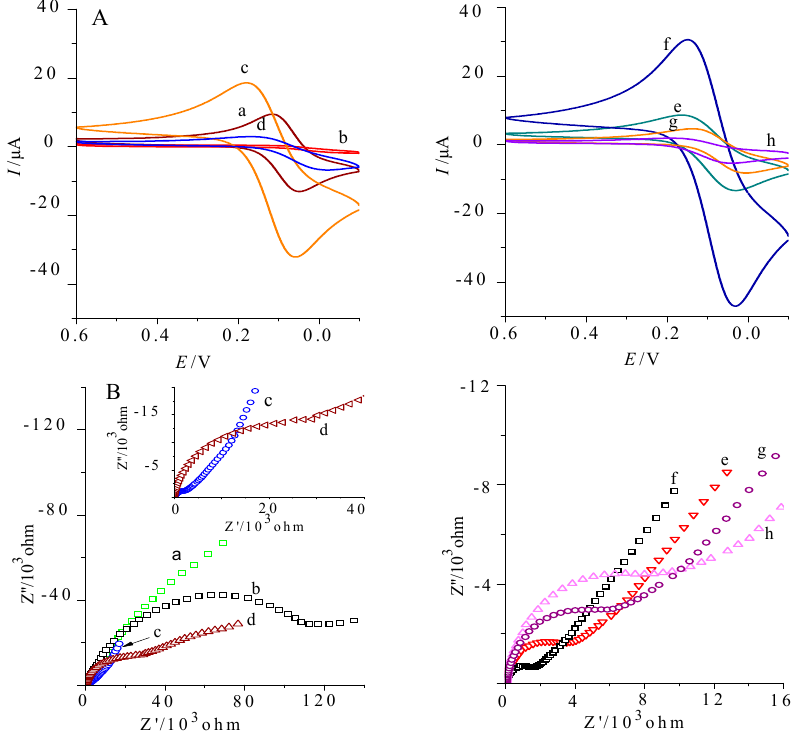
Figure 3. Characterized electrode in modifying process by Cyclic Voltammetry ( A ) and AC